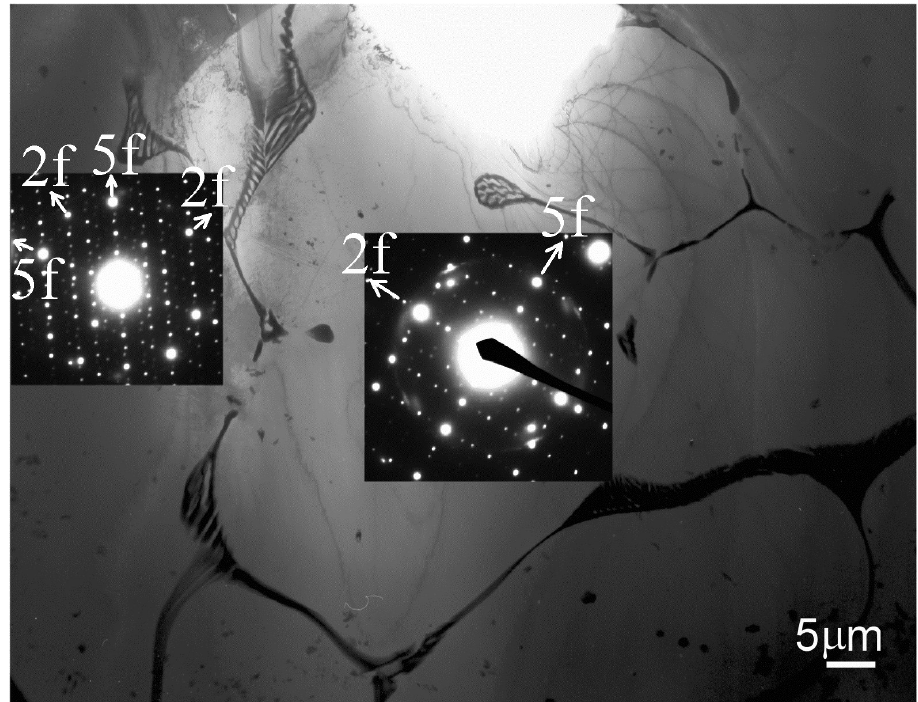
Figure 6. A TEM micrograph from the chill cast alloy showing eutectic phase in interdendritic spaces. The eutectic phase is identified to be i -phaseby electron diffraction patterns inset. 2f and 5f represent twofold and fivefold symmetry reciprocal